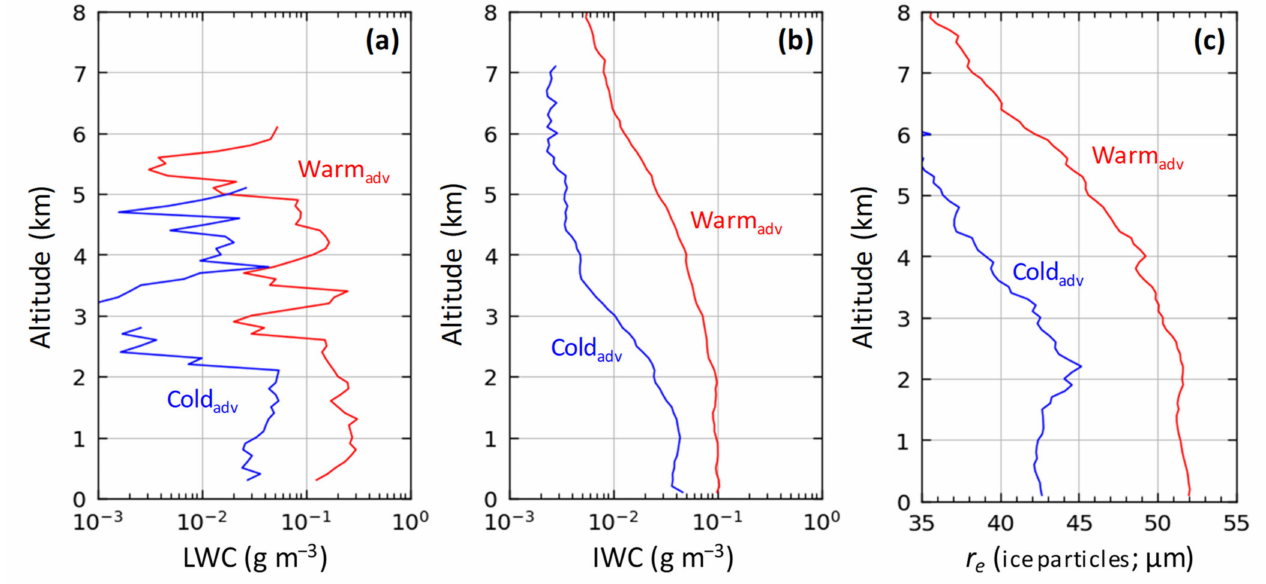
Figure 6. Comparison of the ( a ) LWC, ( b ) IWC, and ( c ) r e of ice particles between warm adv (red) and cold adv (blue)